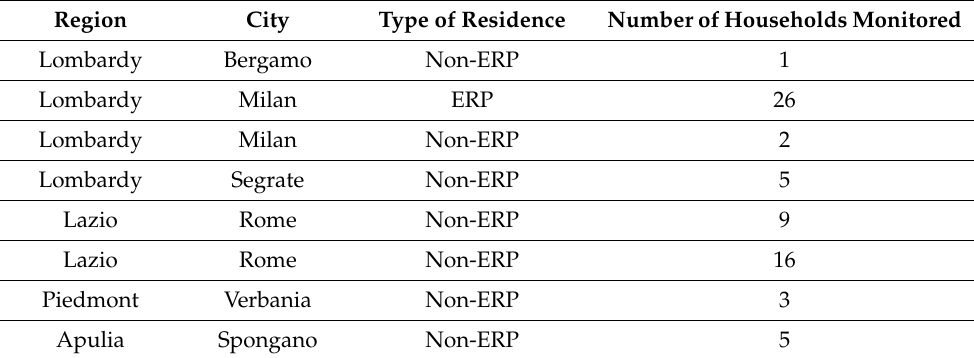
Table 1. Geographical distribution of monitored households.